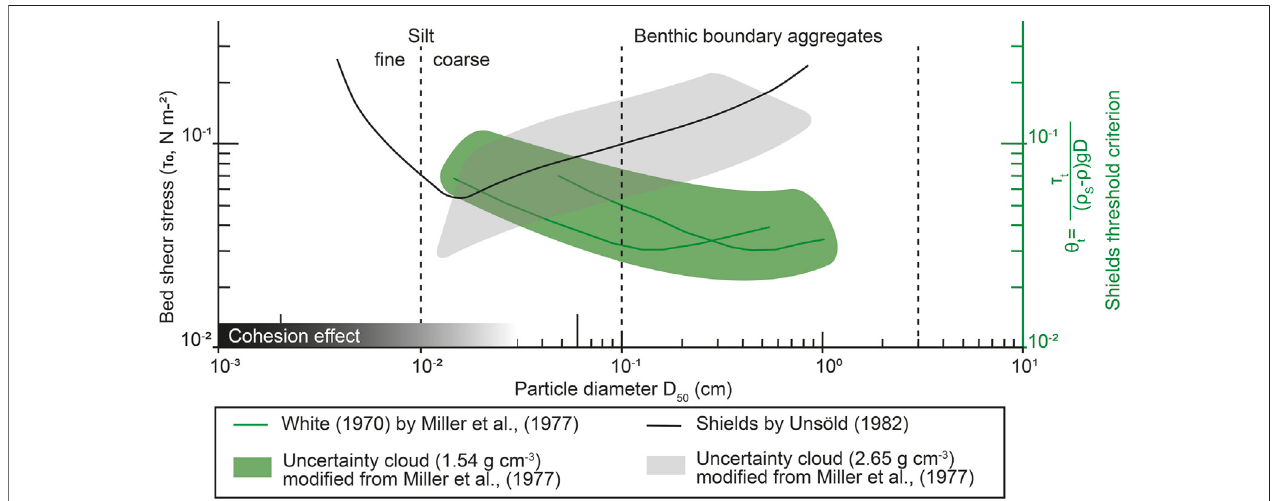
FIGURE9| ConceptualisedShieldsdiagrammodi fi edfromMilleretal.(1977)andThomsenandGust(2000)showingbedshearstress( τ 0 )andtheShieldscriterion ( θ t ) as a function of particle diameter (D 50 ). In green, experiments are reported with low grain densities ( ρ S = 1.54 g cm − 3 ), in black, Unsöld ’ s (1984) modi fi cation of Shields ’ diagram with uncertainty limits (Miller et al., 1977). Both fl uid and grain density variation results in a measurable difference in the threshold of motion, with pure quartz grains showing the onset of the particle cohesion effect at ~30 μ m. None of the experiments deal with the effects of organic matter on sediment cohesion and critical shear